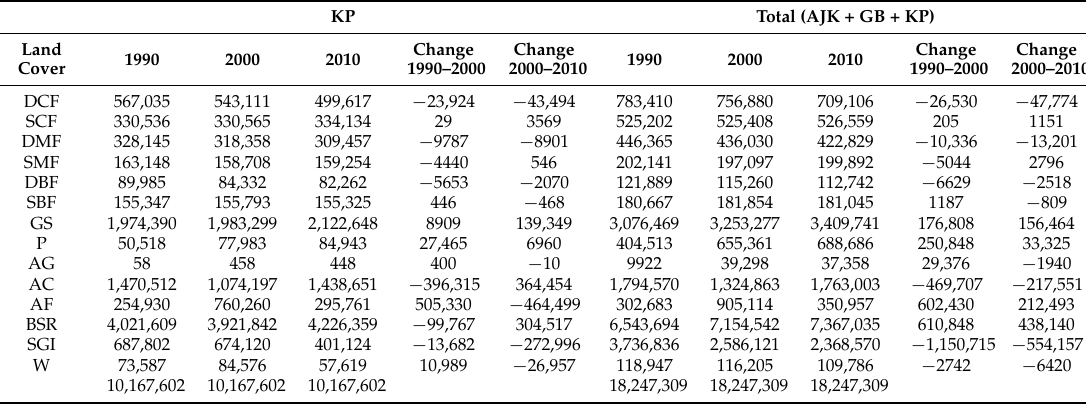
Table 3. Time series land cover statistics of KP and the overall study area. KP Total (AJK + GB +